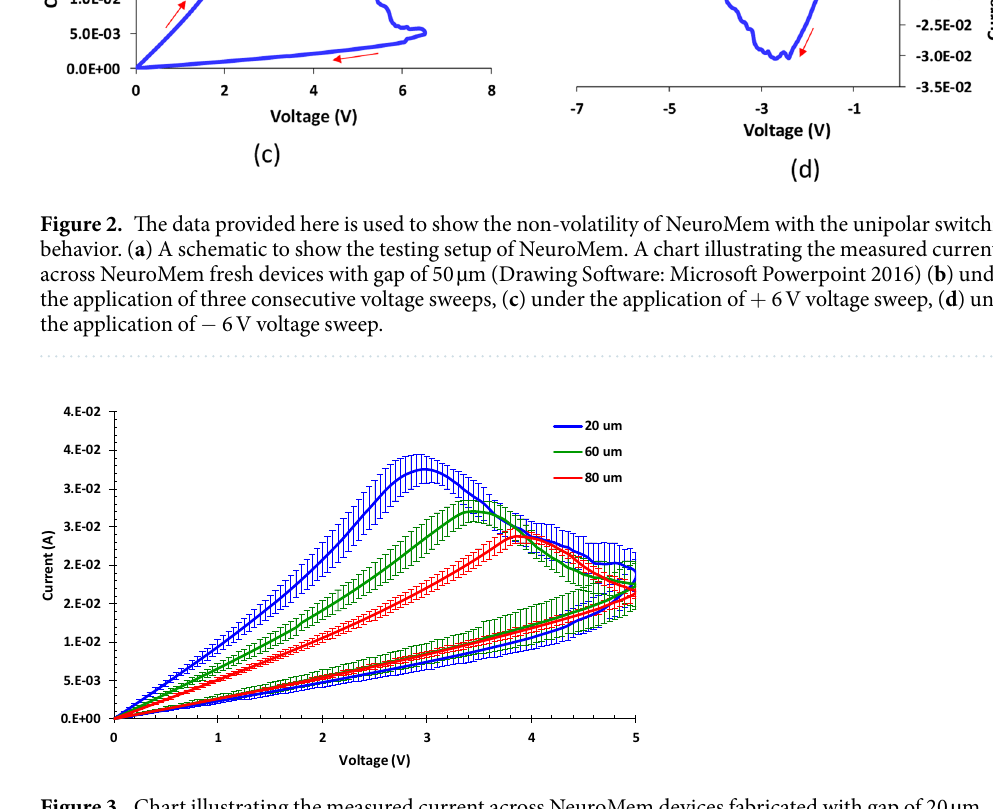
Figure 3. Chart illustrating the measured current across NeuroMem devices fabricated with gap of 20 µ m, 60 µ m, and 80 µ m under the application of + 5 V voltage sweep. For each width gap, the illustrated data represents the average result obtained from 10 identical devices, with error bars for the measured current